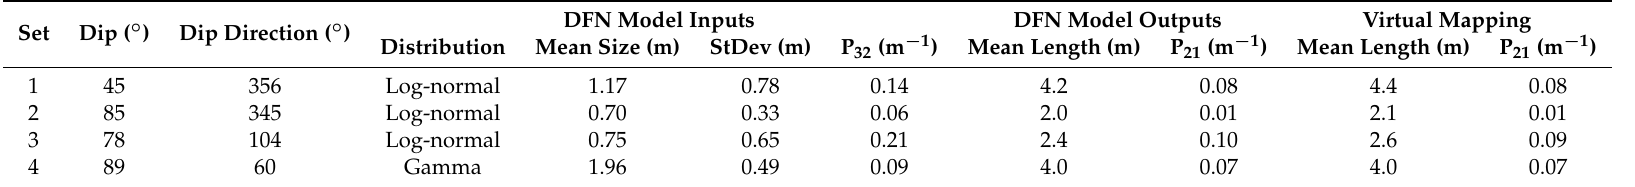
Table 3. Comparison of Mine A virtual mapping data and DFN model data.